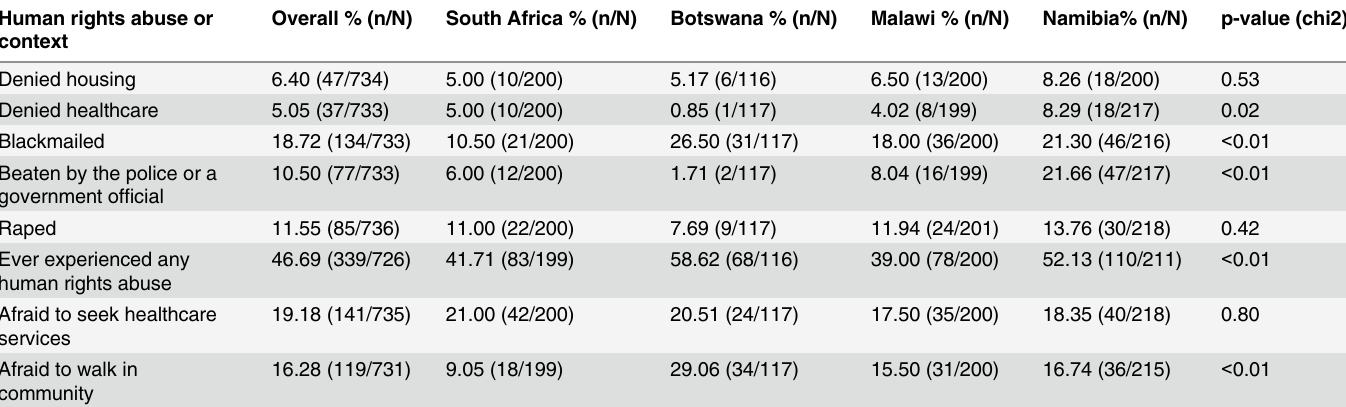
Table 2. Prevalence of human rights abuses reported by MSM in South Africa, Botswana, Malawi, and Namibia.